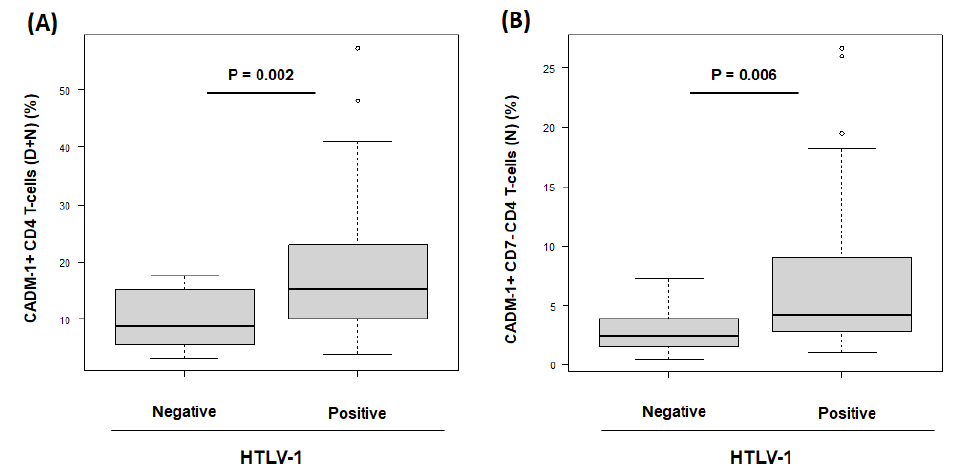
Figure 2. The comparison of CADM1+ CD4+ T-cell populations between human T-cell leukemia virus type 1 HTLV-1-negative and -positive participants with rheumatoid arthritis (RA). ( A ) The box plot of the population of CADM1+ CD4+ T-cells, which present in D + N region, in HTLV-1-negative and -positive RA participants. ( B ) The box plot of the population of CADM1+ CD7neg CD4+ T-cells, which present in N region, in HTLV-1-negative and -positive RA participants.